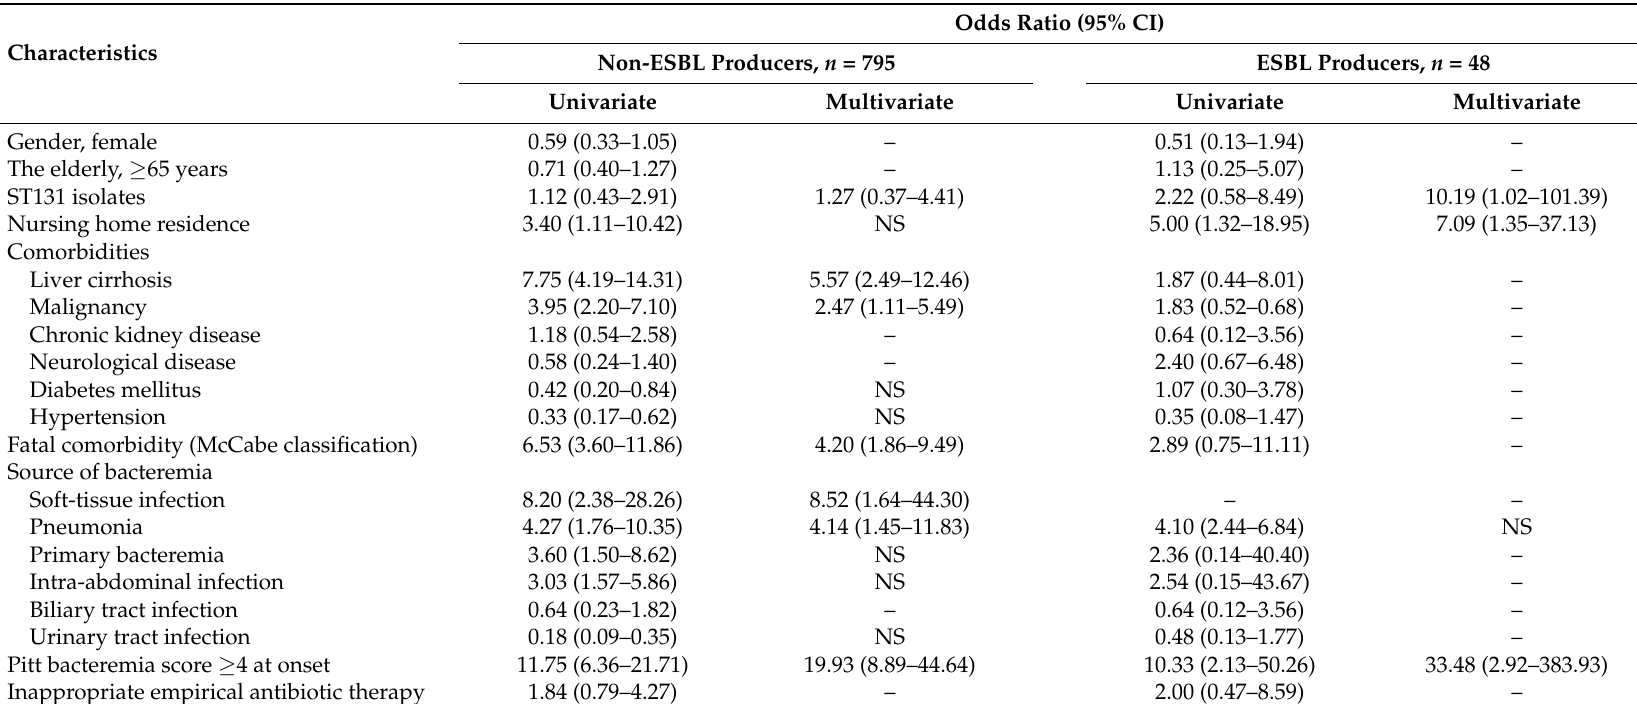
Table 5. Clinical predictors of 28-day mortality in adults with community-onset monomicrobial bacteremia due to Escherichia coli with or without ESBL production.